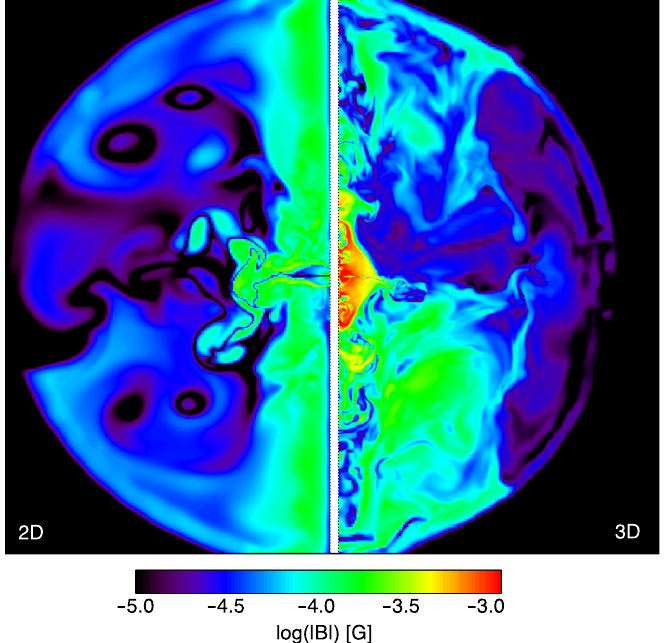
Figure 6. Comparison of the magnetic field intensity (in logarithmic scale and units of G) between a 2D MHD model and a 3D one, which both reproduce the X-ray morphology (from original simulations presented in